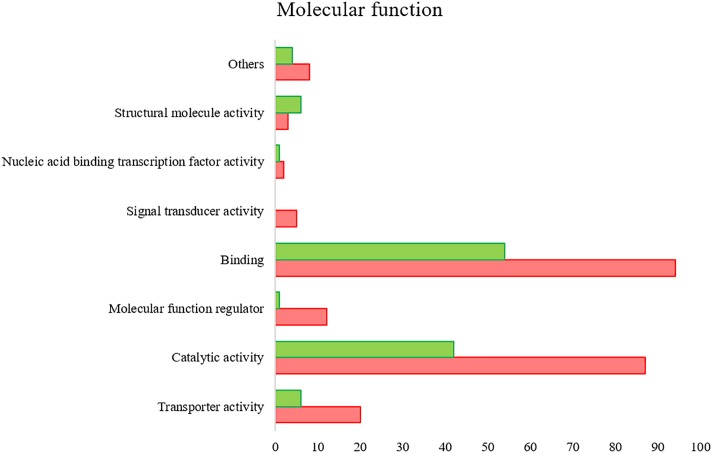
R. annulatus SGs transcriptional response to B. bigemina infection based on GO MF (level 2) of encoded proteins. Red bars represent down regulated genes, green bars represent up regulated genes with statistical significance (p < 0.05).